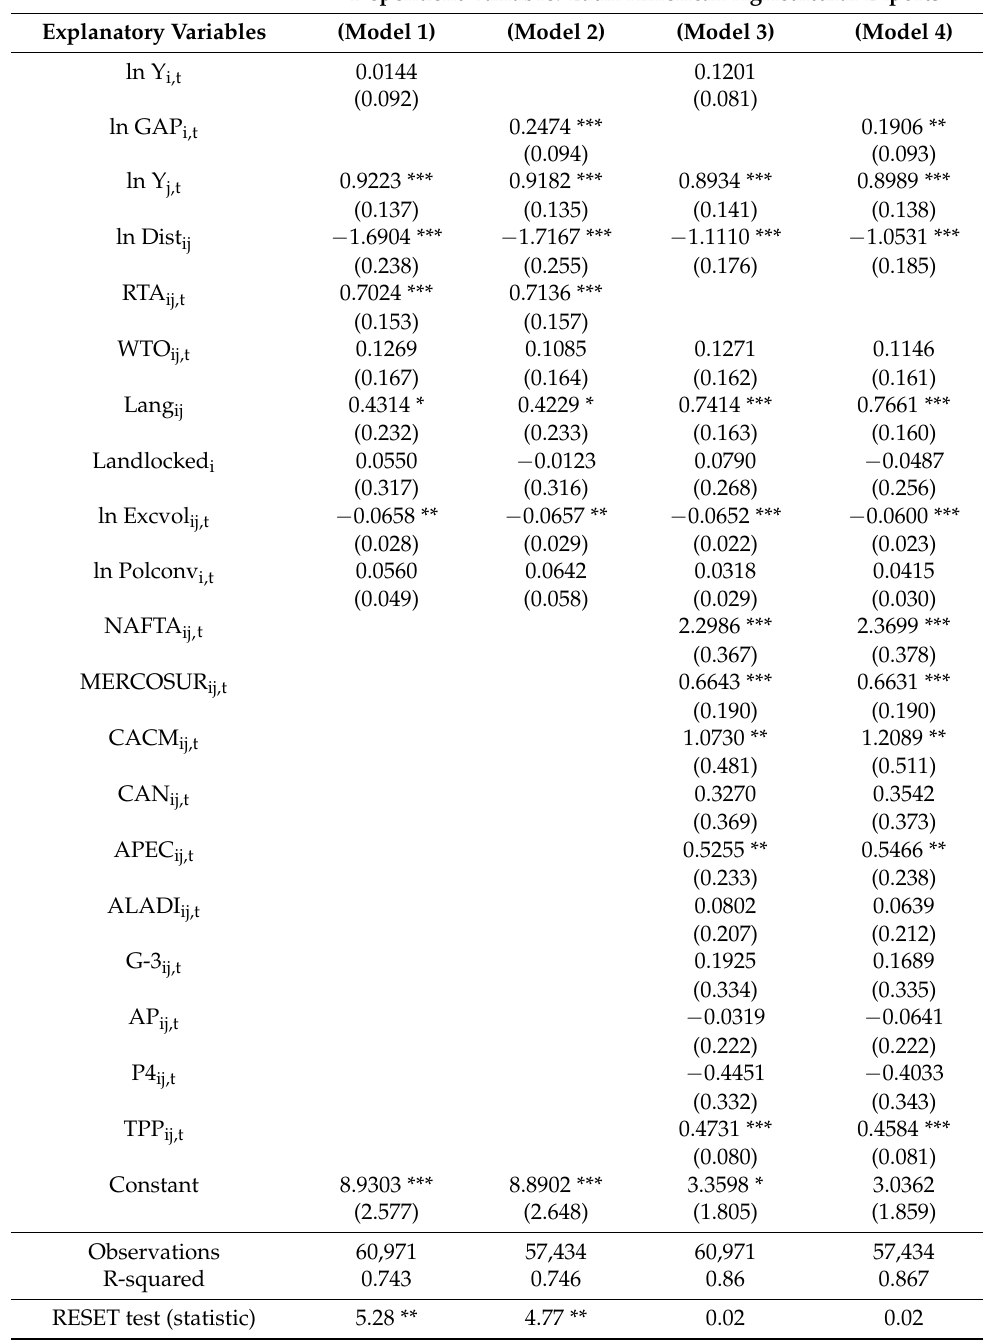
Table 4. Results of the PPML